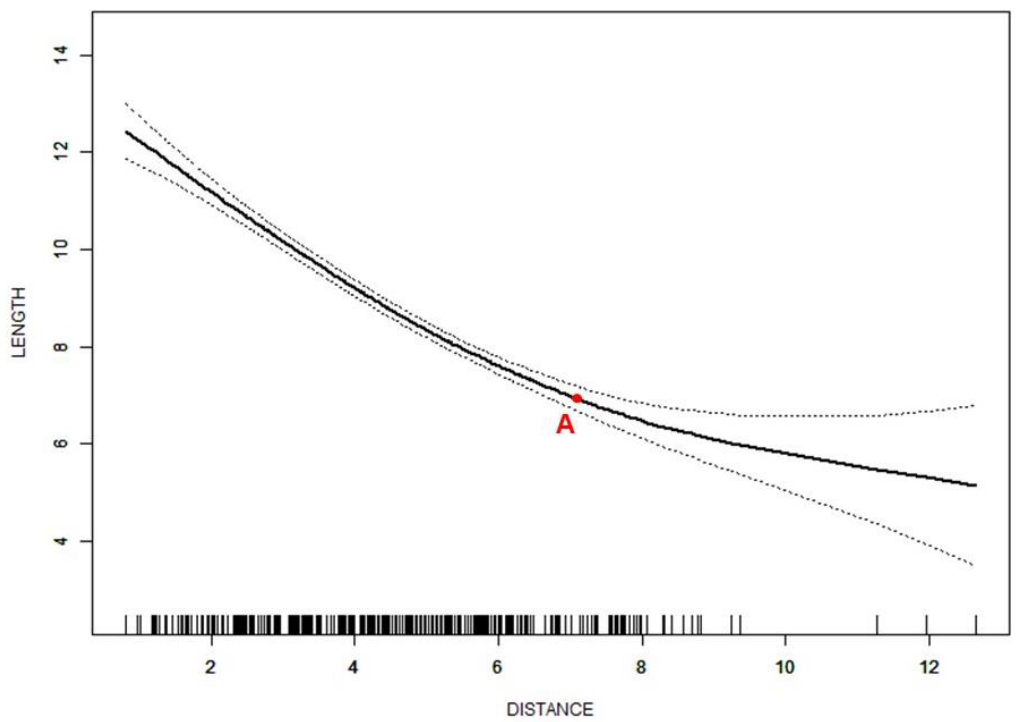
Figure 6. Nonlinear relationship between distance of disc displacement (mm) and disc length (mm) in cases with ADDWoR. Adjusted for age and sex; ADDWoR — anterior disc displacement without reduction; A — the turning point of 7.1 mm.